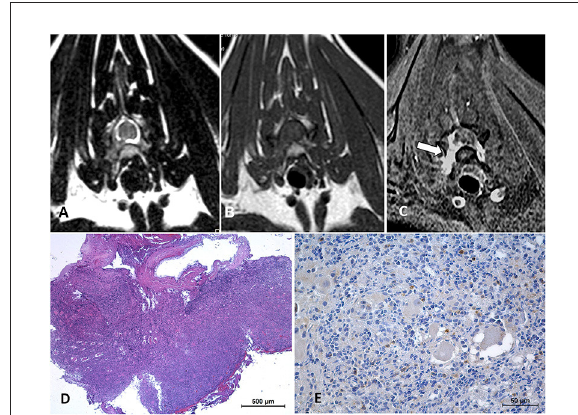
FIGURE2 Cervical neurolymphomatosis in a 2.5-year-old domestic short-haired cat which presented with a 3-month-course of right thoracic limb lameness progressing to monoparesis. In the MRI transverse planes at the level of C6-C7 intervertebral foramina, there is a diffuse enlargement of the right C7 spinal nerve and root with mild spinal cord contralateral displacement (arrows on A–C ). The lesion is iso-hyperintense on T2W images (A) , isointense on T1W (B) , and enhances with an intense and heterogeneous pattern on post-contrast SPIR images (C) . On biopsy tissue (D) neoplastic lymphoid cells are infiltrating adjacent tissues, HE. CD 20-immune positive cells predominate in the neoplastic lymphoid cell population (E) . The final diagnosis was neural and ganglionar small non-cleaved B-cell lymphoma.